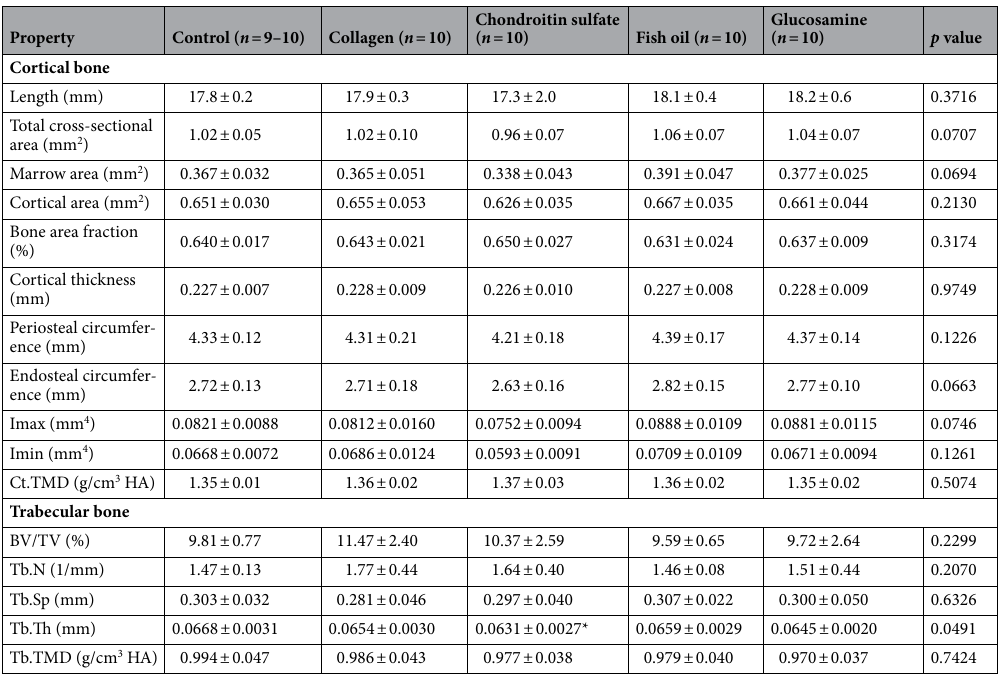
Table 3. Structural properties of the tibiae. Asterisks indicate significant differences when compared to control group. All values are reported as average ± standard deviation. Overall ordinary one way ANOVA or Kruskal Wallis p values are